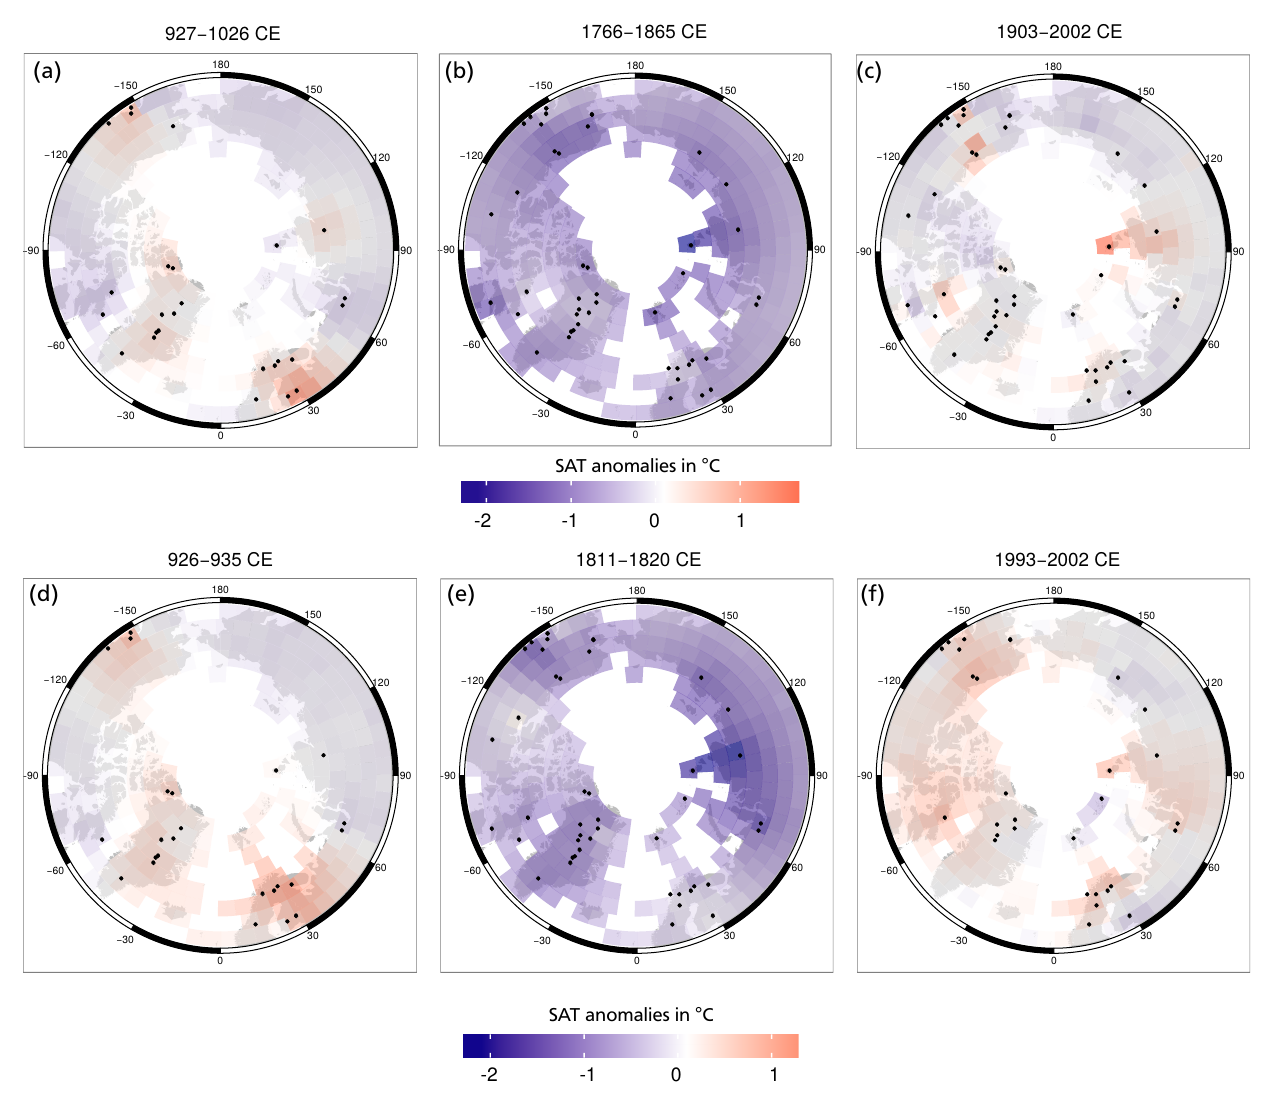
Figure 7. Ensemble average of the reconstructed Arctic2k SAT anomalies over the century- and decade-long periods of (a) 927–1026CE, (b) 1766–1865CE, and (c) 1903–2002CE; (d) Ensemble-average SAT anomaly over the period of 926–935CE, a potentially warmest decade since 750CE with 7 of 10 years top ranked as potentially warmest. (e) Ensemble-average SAT over the period of 1811–1820CE, a potentially coldest decade since 750CE with 7 out of 10 years ranked potentially coldest. (f) Ensemble-average SAT anomaly over the period of 1993– 2002CE, a potentially warmest decade after the MCA with 5 out of 10 years ranked as potentially warmest. Colours show the temperature anomalies. Proxies marked by black